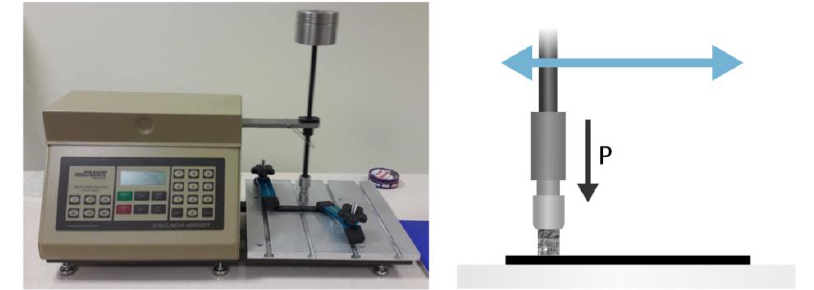
Figure 3. The Taber Linear Abraser model 5750.